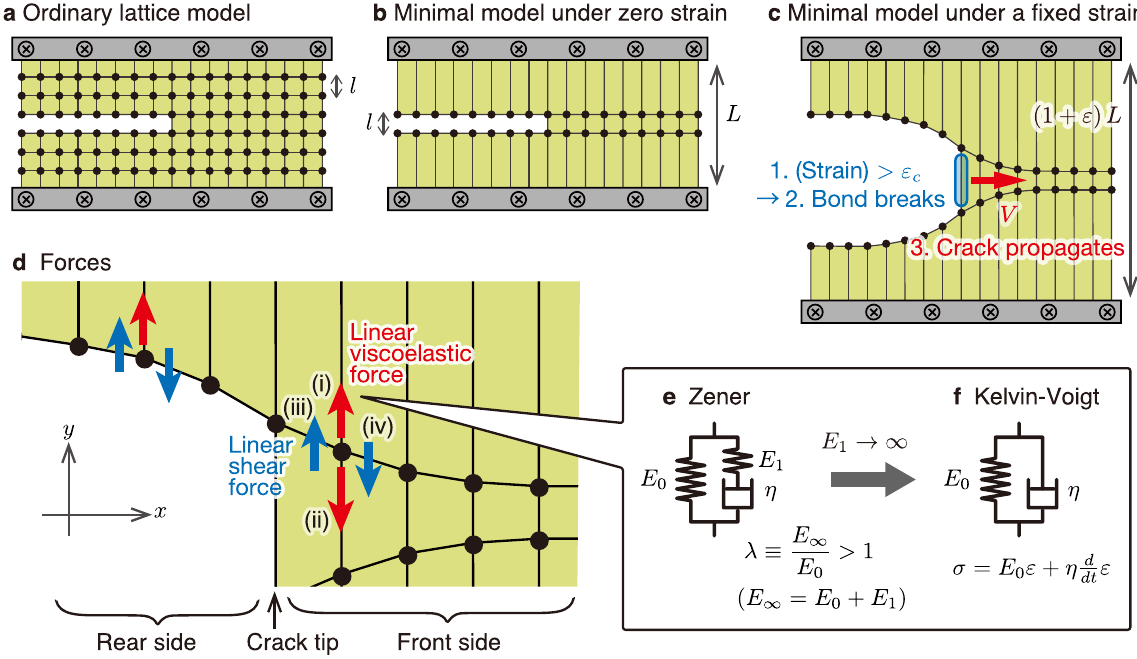
Figure 2. Minimal model for the straight-line crack propagation. ( a ) Two-dimensional square-lattice model of a sheet with a line crack. Here, l is the lattice spacing. Each lattice point interacts with the nearest-neighbor points. We introduce a line crack by cutting bonds, i.e., we set the interactions of the corresponding bonds to zero. ( b ) Minimal model obtained by coarse-graining the lattice in ( a ). We decimate all the lattice points except for the points on the two horizontal lines on which the two surfaces of the line crack are positioned, where L is the height of the sheet under zero strain. ( c ) Mechanism of the crack propagation. When the spring at the crack tip (encircled by a blue ellipse) is stretched to the critical strain ε c , the bond at the tip breaks, and, after a certain time, the next bond at the tip is stretched to ε c . This cycle continues during the crack propagation. ( d ) Forces acting on a lattice point. On each point in ( c ) located at the front side of the crack tip, four forces act: (i) one from the top boundary, (ii) one from the point below, and (iii, iv) the remaining two reflecting shear and acting from the left and right nearest-neighbor points. For each point located at the rear side, one force from the point below is missing. ( e ) Zener element. This element is a parallel connection of two components: a spring (elastic modulus E 0 ) and a Maxwell element, i.e., a serial connection of another spring (modulus E 1 ) and a dashpot (viscosity η ). ( f ) Kelvin-Voigt element obtained from a Zener element in the large E 1 limit, in which → ∞ λ ≡ E ∞ / E 0